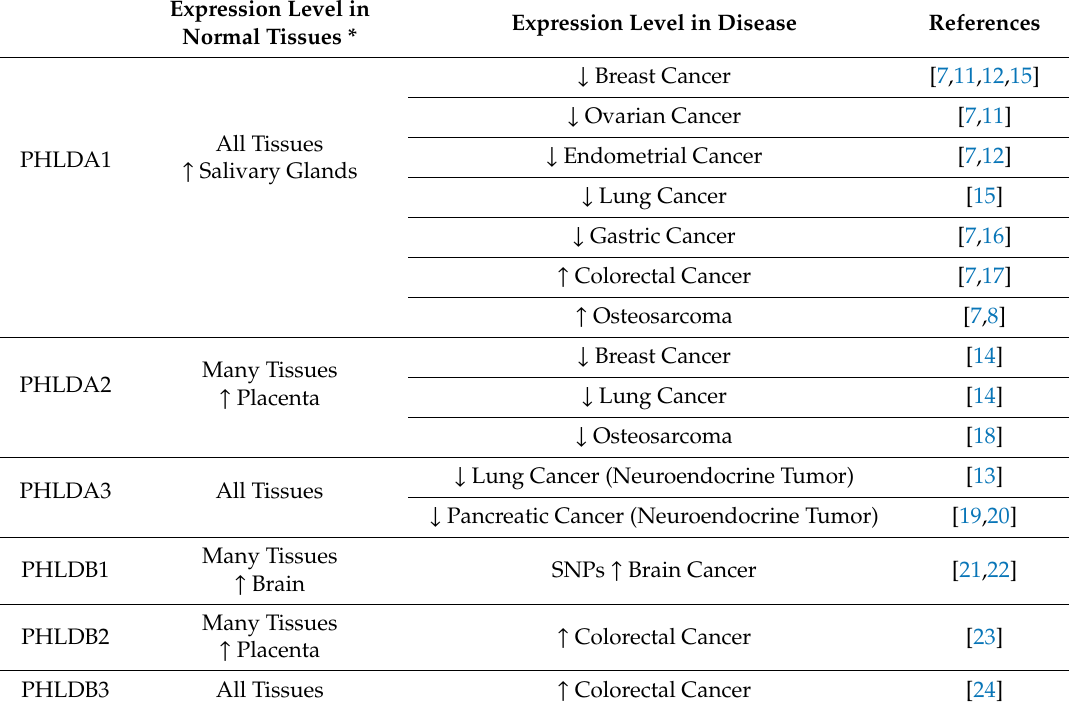
Table 1. PHLD Class Proteins and